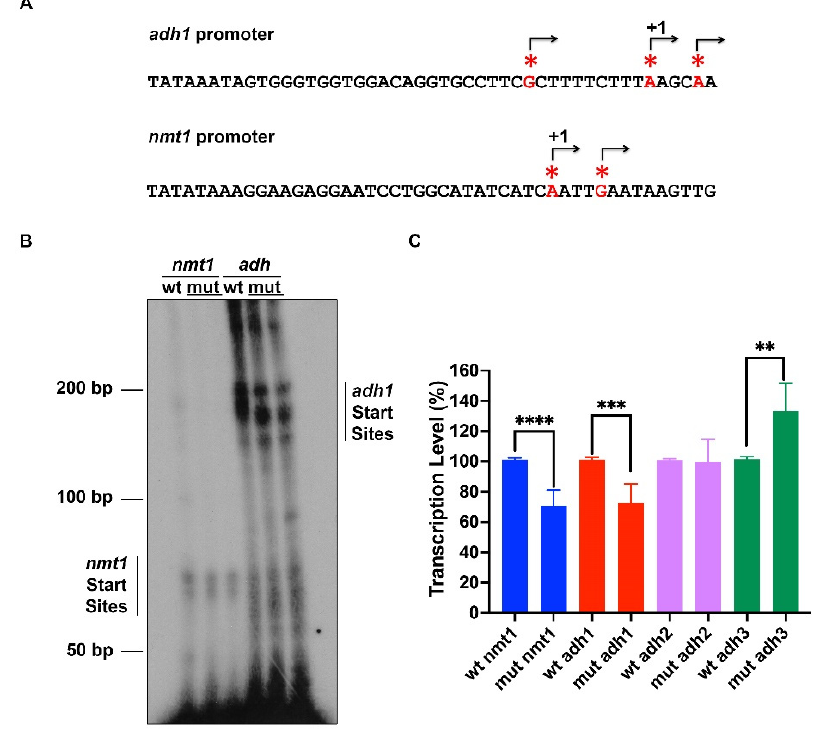
Figure 6. Replacement of SpIIB by PcIIB does not change the in vivo TSS in the nmt1 and adh1 gene promoters. ( A ) In vitro and in vivo TSS from the adh1 and nmt1 genes. Red asterixes and arrows indicate the TSS of each gene. +1 indicates the major TSS of adh1 and nmt1 gene promoters. ( B ) Total RNA was isolated from wild-type and PcIIB-replaced (mut) fission yeast cells, which were grown in minimal medium. The RNA (1 µ g) was analyzed by primer extension using a radiolabeled oligonucleotide and the products were analyzed using a 10% polyacrylamide-urea gel, followed by autoradiography. The products indicated by a bar are correctly initiated transcripts from the nmt1 and adh1 gene promoters. The wild-type strain and two different clones of PcIIB-replaced strain were analyzed (mut). ( C ) Quantification of the start sites is indicated. Three adh start sites were analyzed from the top (adh1) to the bottom (adh3). Comparison of transcription levels was performed using a Student’s t -test. ** indicates p < 0.005; *** indicates p < 0.001; **** indicates p <